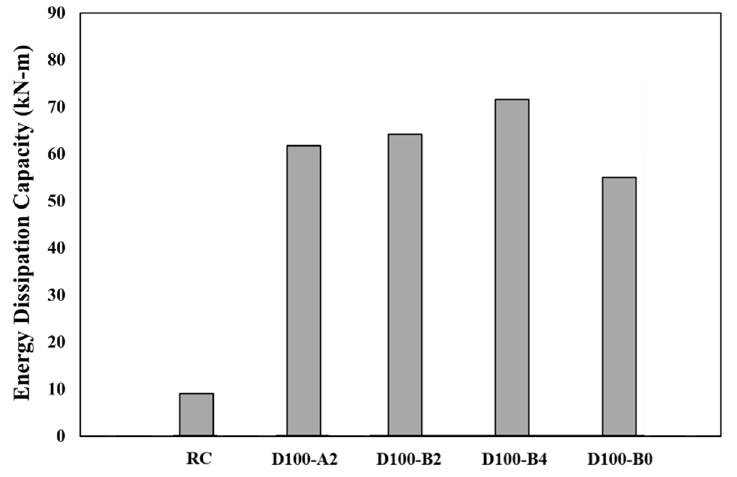
Figure 17. Analysis of energy dissipation capacities.